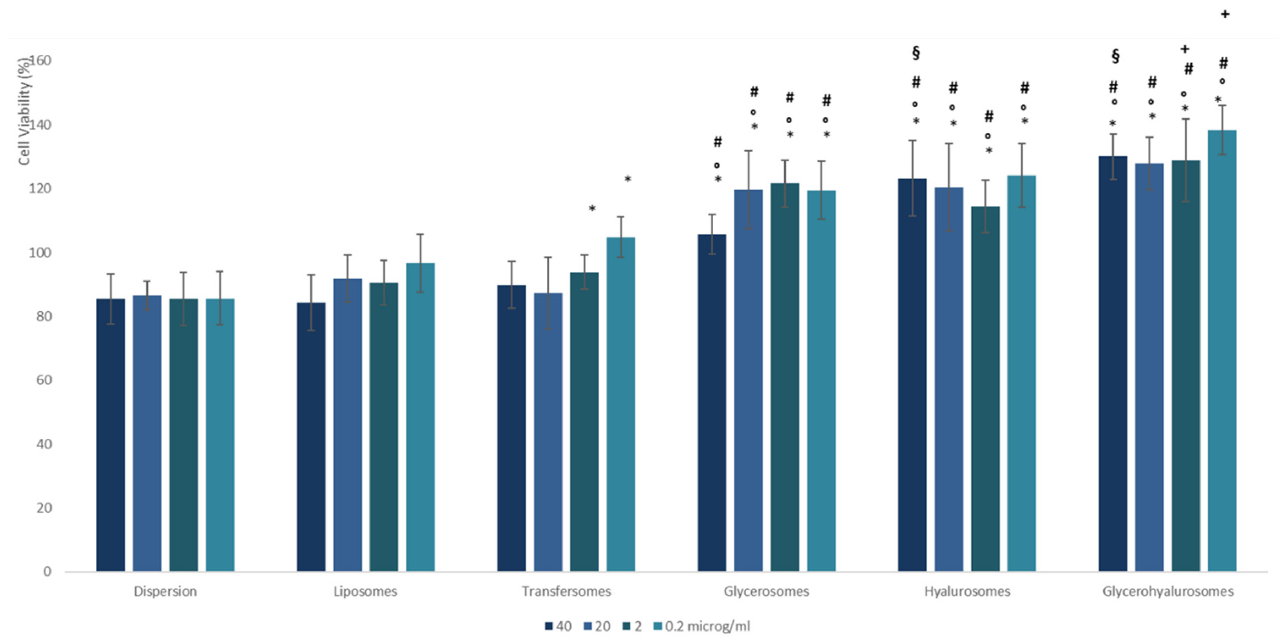
Figure 4. Viability of fibroblasts incubated for 48 h with the T. marum extract in dispersion or loaded in vesicles. Mean values ± standard deviations are reported. The symbol * indicates values statistically different from the extract in dispersion ( p < 0.05); the symbol ◦ indicates values statistically different from liposomes ( p < 0.01); the symbol # indicates values statistically different from transfersomes ( p < 0.01); the symbol § indicates values statistically different from glycerosomes ( p < 0.05) and the symbol + indicates values statistically different from hyalurosomes ( p < 0.01).